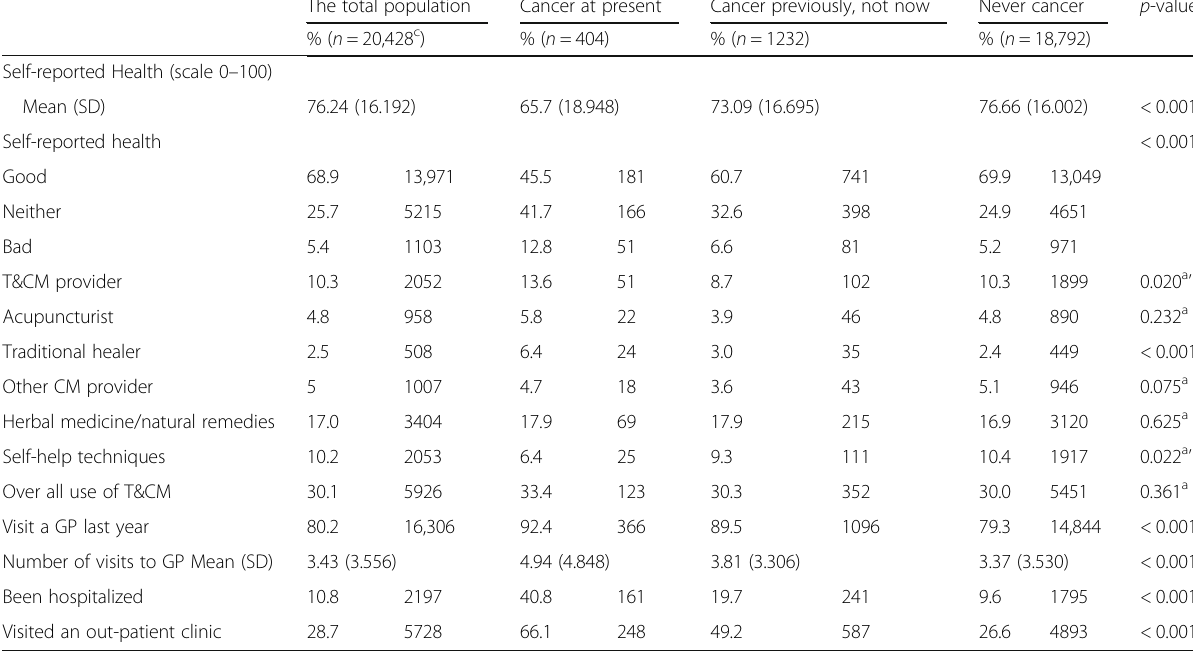
Table 2 Self-reported health and use of health care services among the participants The total population Cancer at present Cancer previously, not now Never